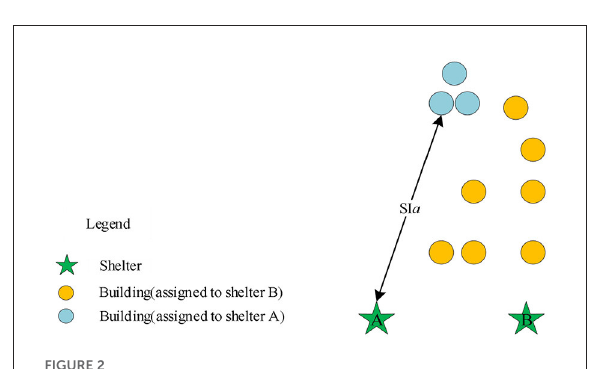
FIGURE2 The scenario analysis of the spread initial